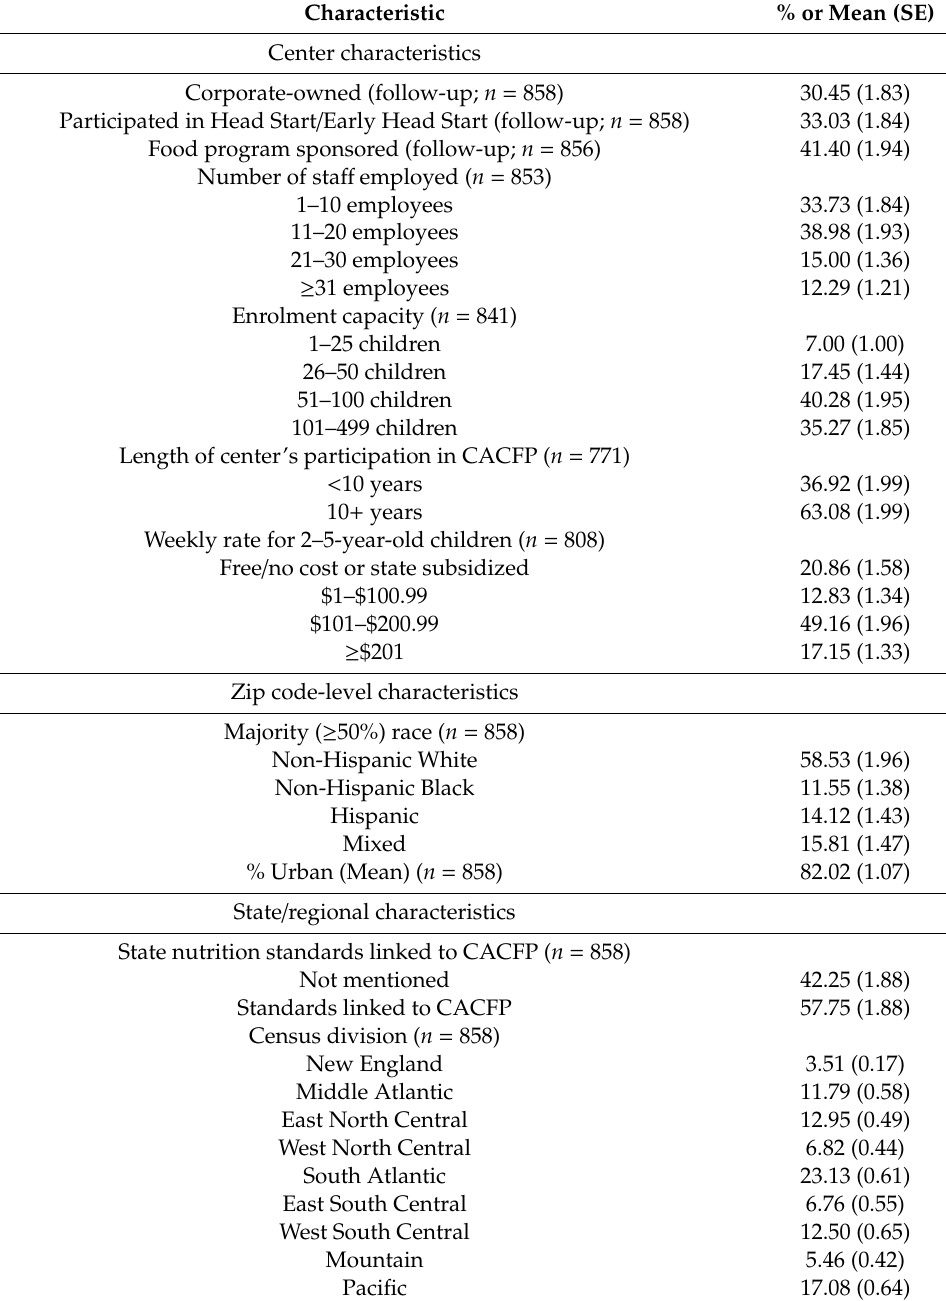
Table 1. Characteristics of the study